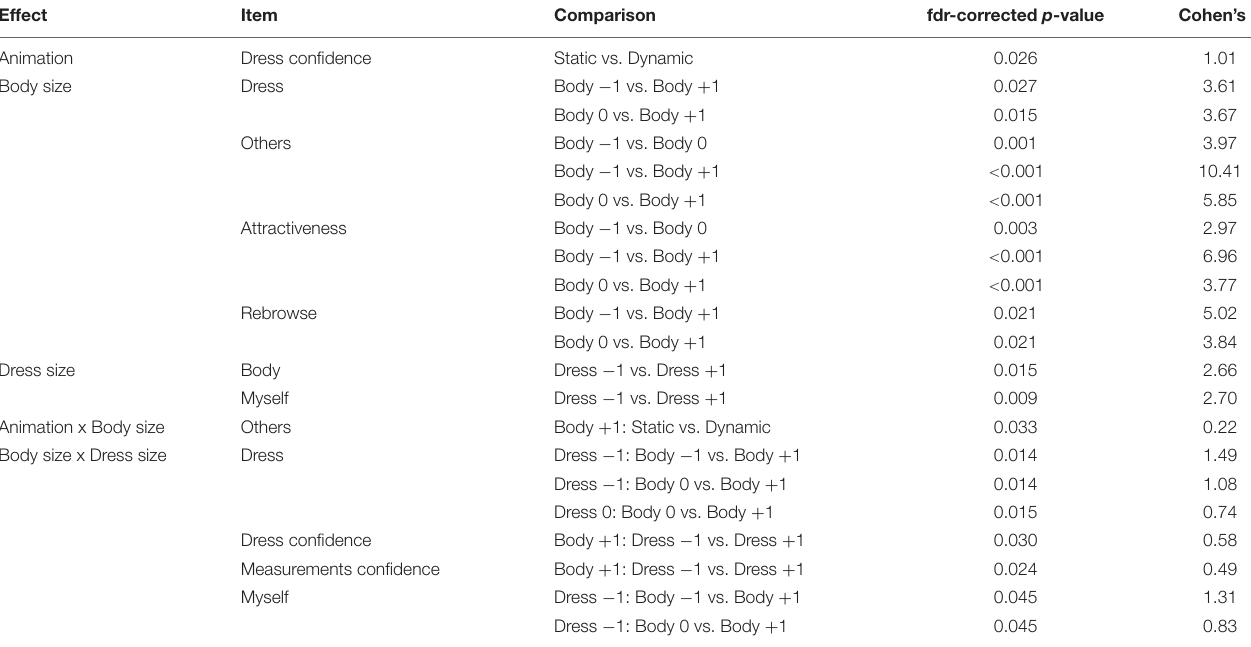
TABLE 3 | Pairwise comparisons of the main and interaction effects of Animation, Body size, and Dress size.